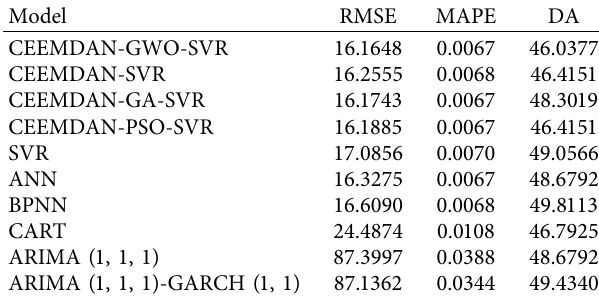
Table 7: Out-of-sample forecasting accuracy